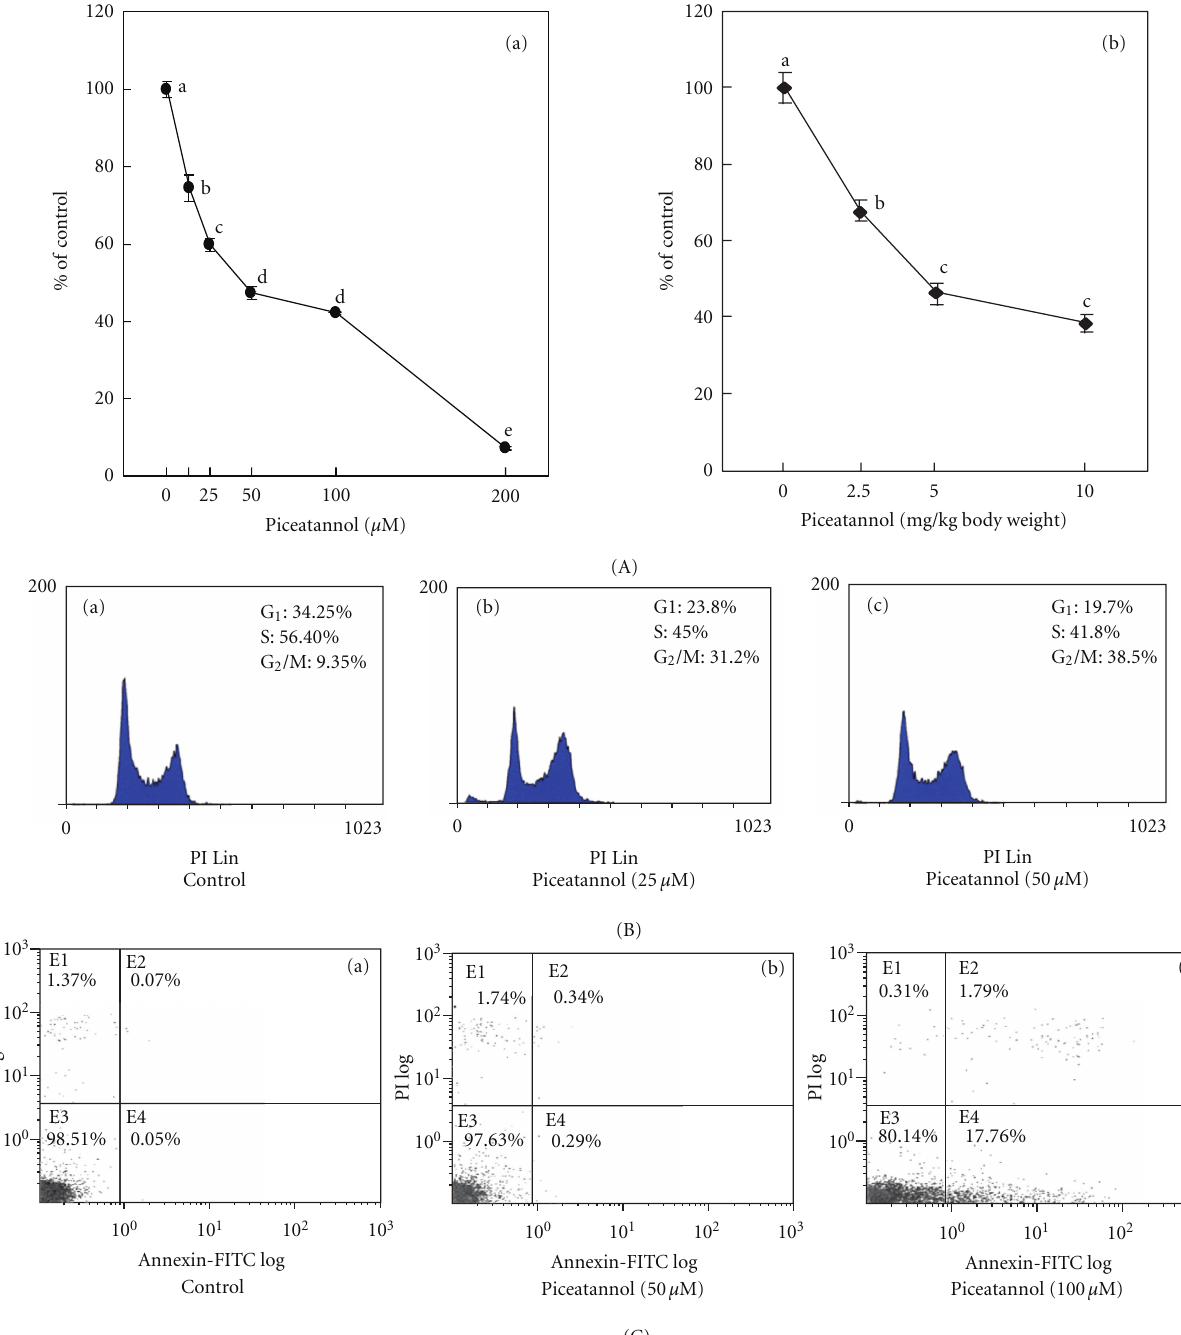
Figure 1: E ff ect of piceatannol on the proliferation (A), cell cycle (B), and apoptosis of AH109A hepatoma cells (C). (A) Piceatannol was dissolved in ethanol. The piceatannol solution was added to the culture medium at a final ethanol concentration of 0.2%. Piceatannol was suspended in a 0.3% carboxymethyl cellulose sodium salt (CMC) aqueous solution at concentrations of 0.25, 0.5, and 1 mg/mL. Piceatannol suspension or 0.3% CMC alone (vehicle control) (1mL/100g body weight) was intubated to male Donryu rats which had been fasted overnight, and blood was collected 2h after oral administration. The proliferative activity was determined by [methyl- 3 H]thymidine incorporation method in vitro (A(a)) and ex vivo (A(b)). Each value represents the mean ± SEM of six wells. Values not sharing a common letter are significantly di ff erent at P < 0 . 05. (B) For cell cycle analysis, 3.0 × 10 5 cells of AH109A per well were seeded in the medium containing 0, 25, and 50 μ M piceatannol and cultured for 24h. Cells were then collected and washed twice with PBS( − ). Thereafter, propidium iodide (PI) solution was added and cells were incubated for 30 min on ice. Cells at di ff erent cell cycle phases were then analyzed with a flow cytometer. Data are from representative experiment repeated three times with similar results (B(a)–(c)). (C) The e ff ect of piceatannol on apoptosis in AH109A cells was assessed using Annexin V-FITC kit according to the manufacturer’s instructions. Briefly, 5 × 10 5 cells of AH109A per well were seeded in a 6-well plate and cultured in the medium containing 0, 50, and 100 μ M piceatannol for 3 h. At the end of culture, cells were labeled with Annexin-V-FITC and analyzed with a flow cytometer. Data are from representative experiment repeated three times with similar results